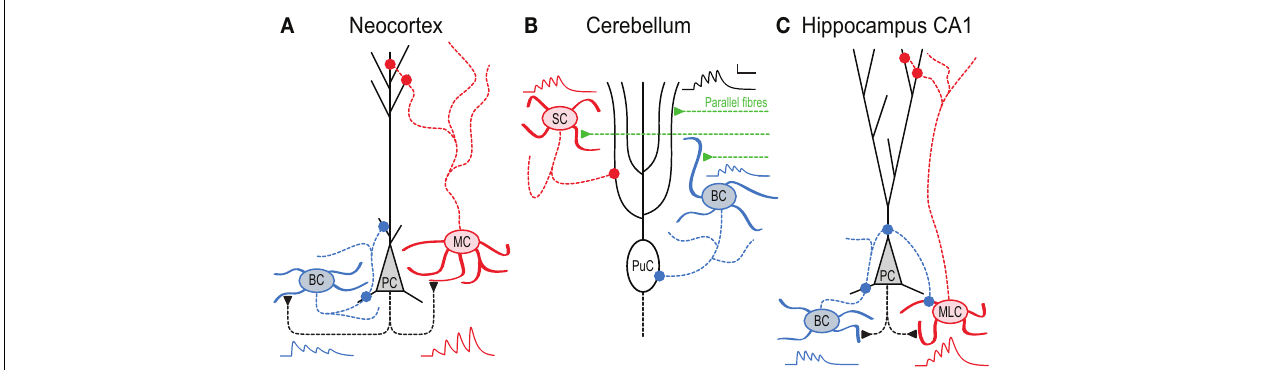
FIGURE 1 | In local circuits, target-cell specific STP remaps spiking across the somato-dendritic axis. (A) Pyramidal cell (PC) inputs to basket cells (BC) are short-term depressing, whereas those to Martinotti cells (MC) are facilitating (Markram et al., 1998). As a result, high-frequency PC firing (Larkum et al., 1999; Murayama et al., 2009) activates MCs later than BCs, an effect that is amplified by presynaptic NMDA receptors ( Figure 3 and Buchanan et al., 2012). BCs in turn innervate PCs perisomatically (Buchanan et al., 2012), whereas MCs contact the apical dendrite (Silberberg and Markram, 2007). (B) In cerebellum, synapses between parallel fibers (PF) and Purkinje cells (PuC) facilitate, as do connections to stellate cells (SC). In contrast, PF synapses onto BCs depress, so high-frequency PF activity